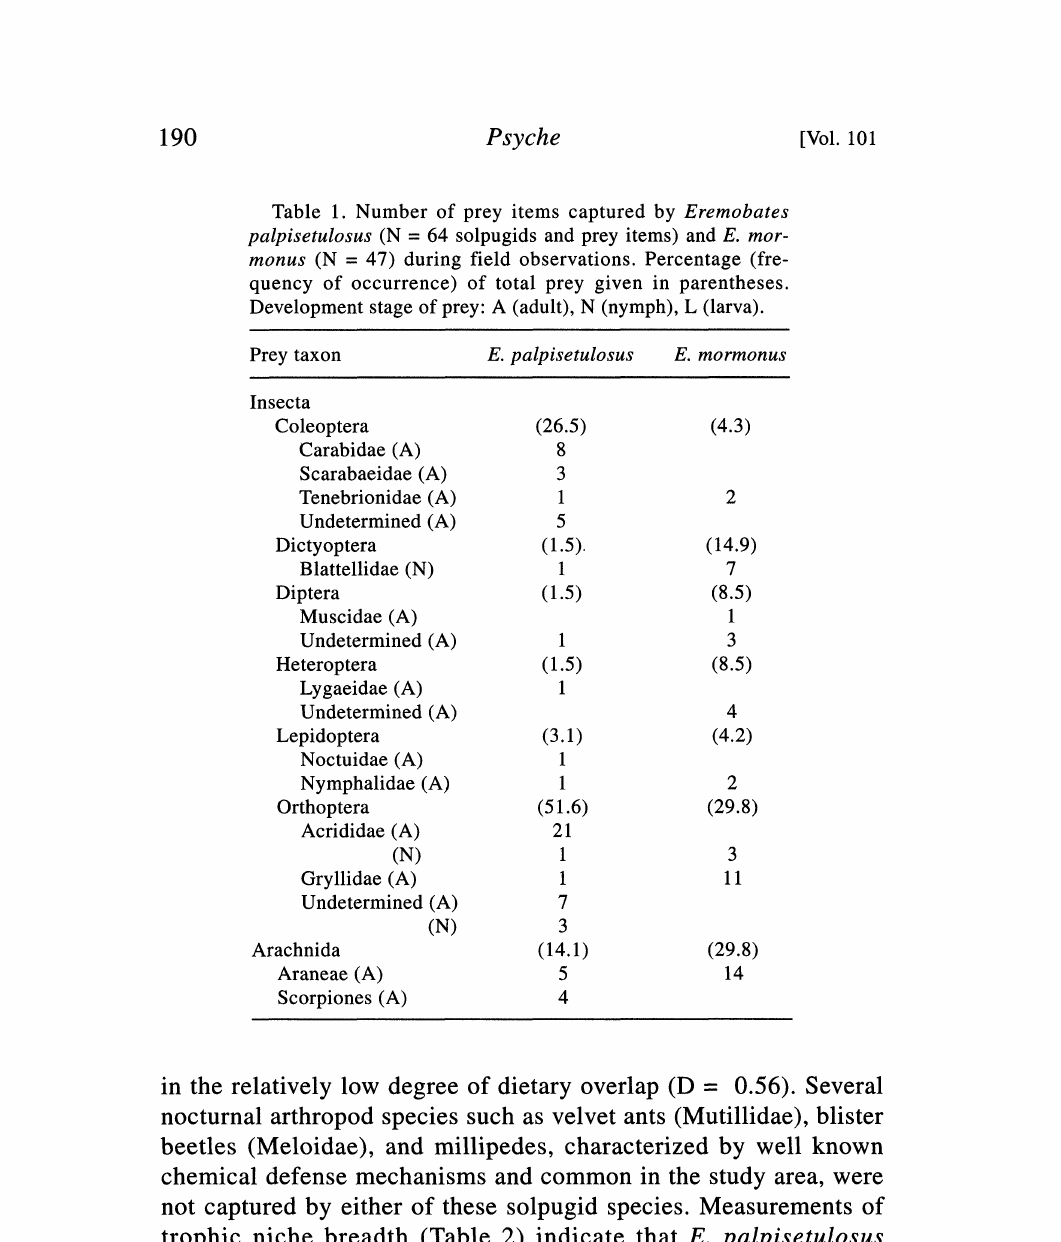
Table 1. Number of prey items captured by Eremobates palpisetulosus (N 64 solpugids and prey items) and E. mor- monus (N 47) during field observations. Percentage (fre- quency of occurrence) of total prey given in parentheses. Development stage of prey: A (adult), N (nymph), L